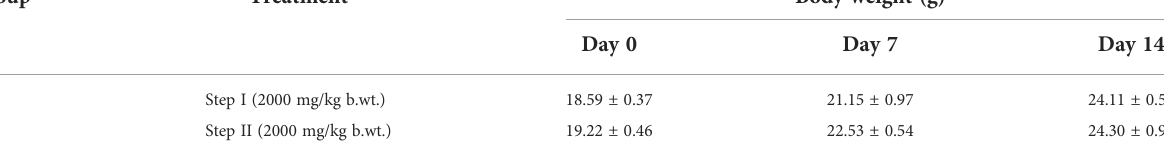
TABLE 1 Body weight of the experimental animals.